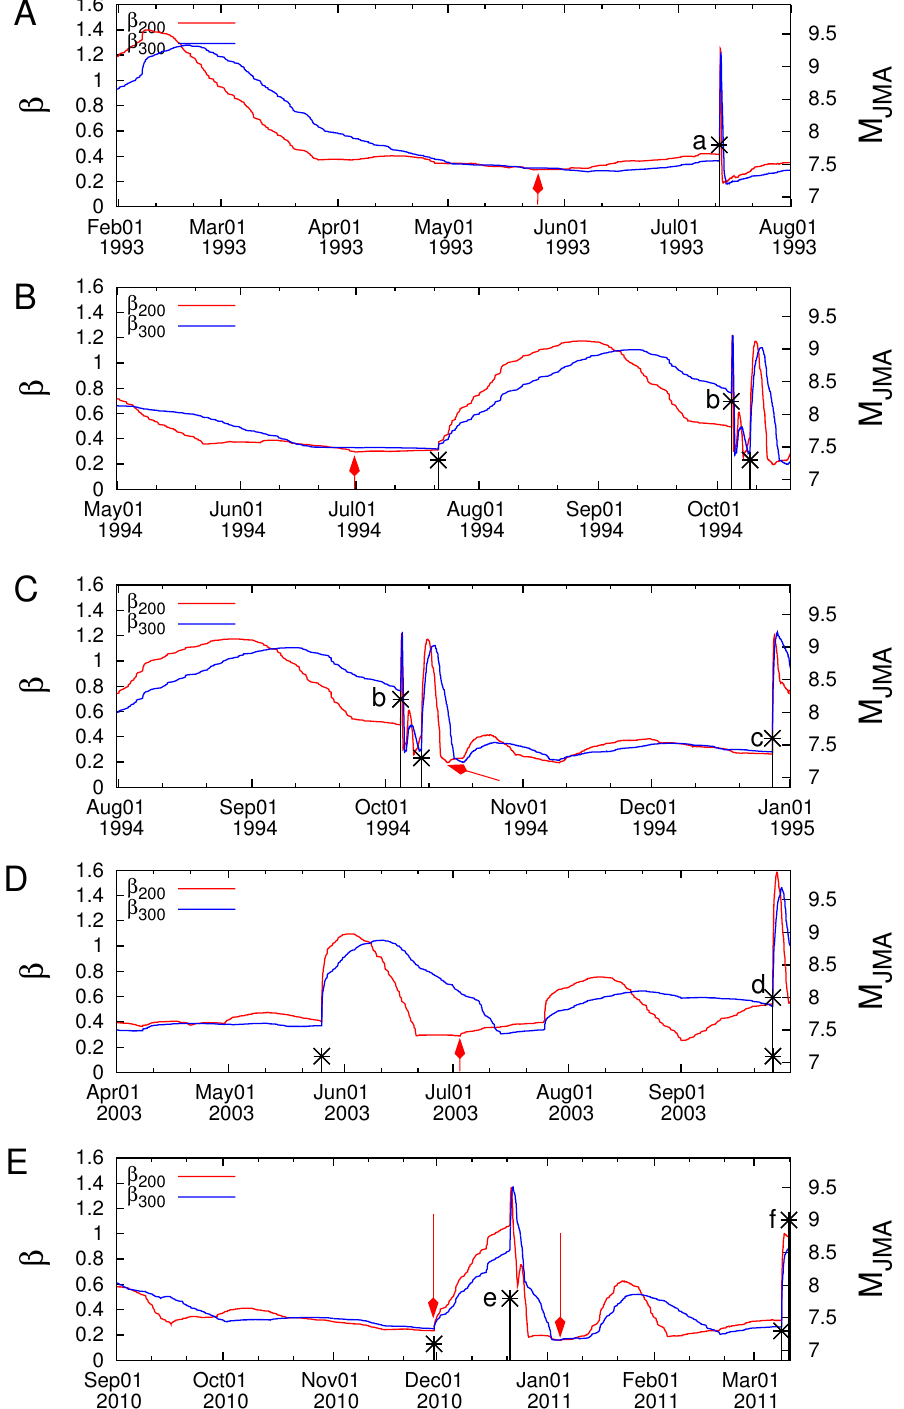
Figure 6. Excerpts of Figure 5 plotted in an expanded time scale showing what happened for the variability β before the occurrence of ( A ) EQa, ( B ) EQb, ( C ) EQb and EQc, ( D ) EQd, and ( E ) EQe and EQf (the M 9 Tohoku EQ). Every tick corresponds to 10 days in the horizontal scale. The red arrows show β 200, min along with EQs (in black asterisks, a–f, M JMA in the right scale). Taken from Ref.